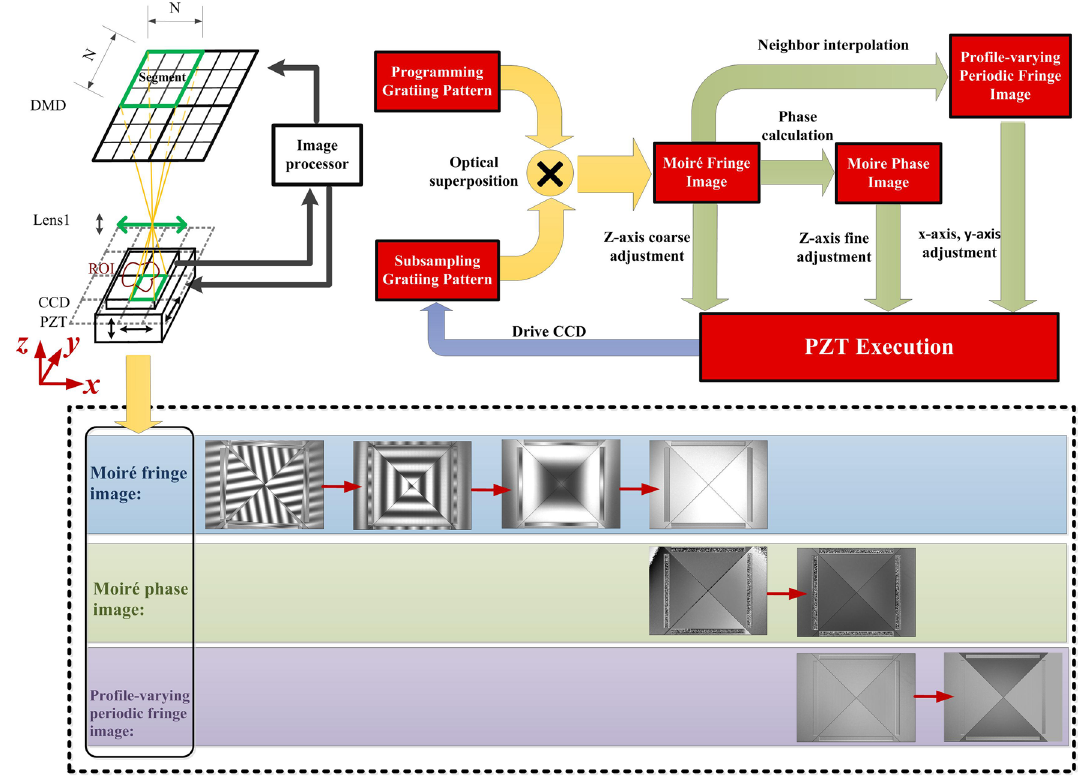
Figure 2. The closed-loop system for accurate alignment between CCD and DMD.